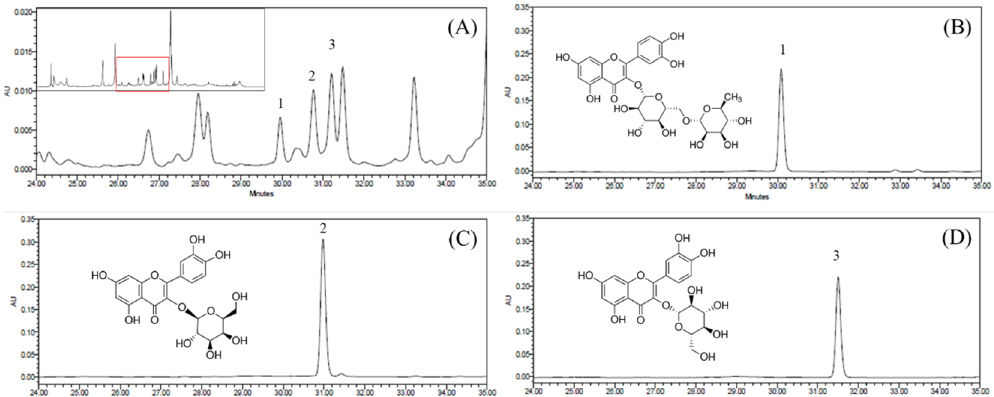
Figure 1. HPLC chromatograms of PUL extract and standard samples. Detection interval of ( A ) extract, ( B ) rutin, ( C ) hyperoside, and ( D ) isoquercitrin.